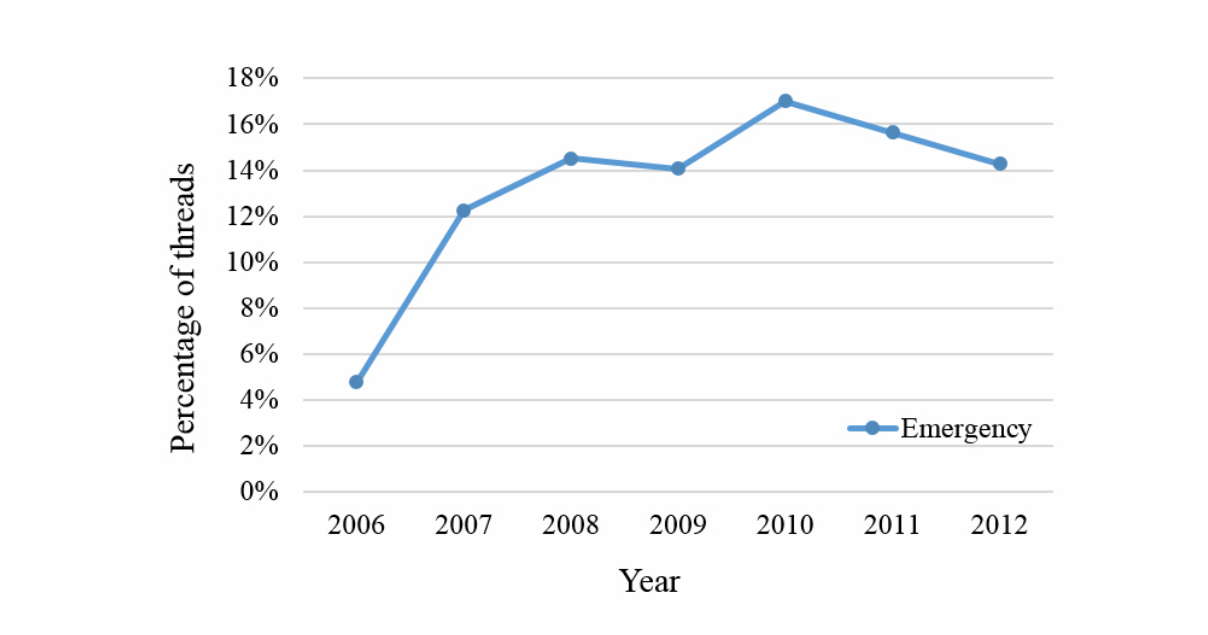
Figure 7. Percentage of threads that mention “Emergency” in the Daegu